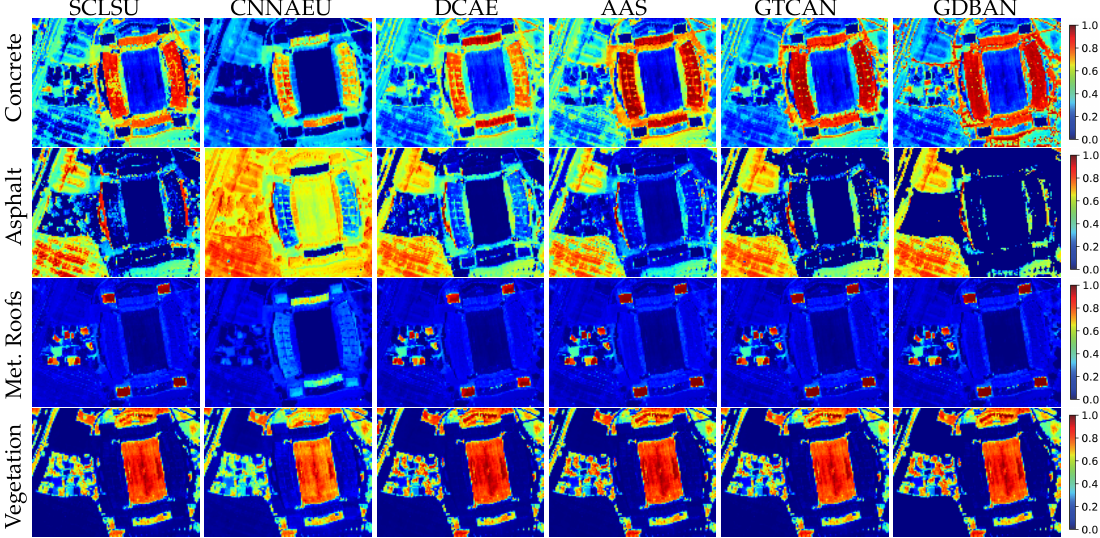
Figure 10. Estimated abundance maps on Houston data by different methods. Table 5. Quantitative results on Houston data. The optimal results are